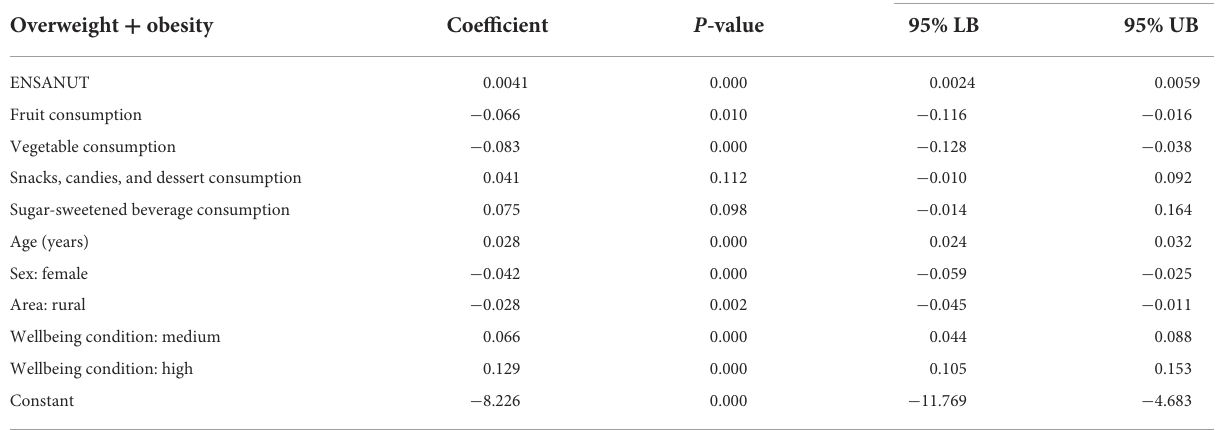
TABLE 3 Linear mixed model for the contribution of food group intake on overweight +